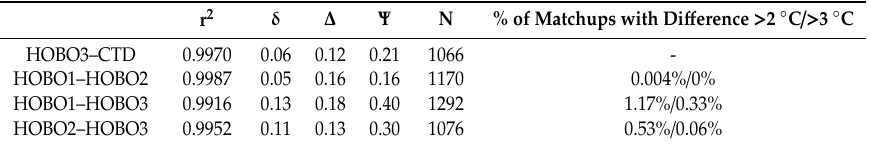
Table 1. Comparison statistics between the CTD, the HOBO1, the HOBO2, and the HOBO3 datasets. The squared Pearson correlation coe ffi cient (r 2 ), the mean bias ( δ ), the mean absolute error( ∆ ), the root mean squared error ( Ψ ), and the number of matchups taken into account (N) are presented for daily averaged values. The last column refers to the percentage of the raw data matchups—not the daily averaged—that had di ff erence over > 2 ◦ C / > 3 ◦ C, respectively. r 2 δ ∆ Ψ